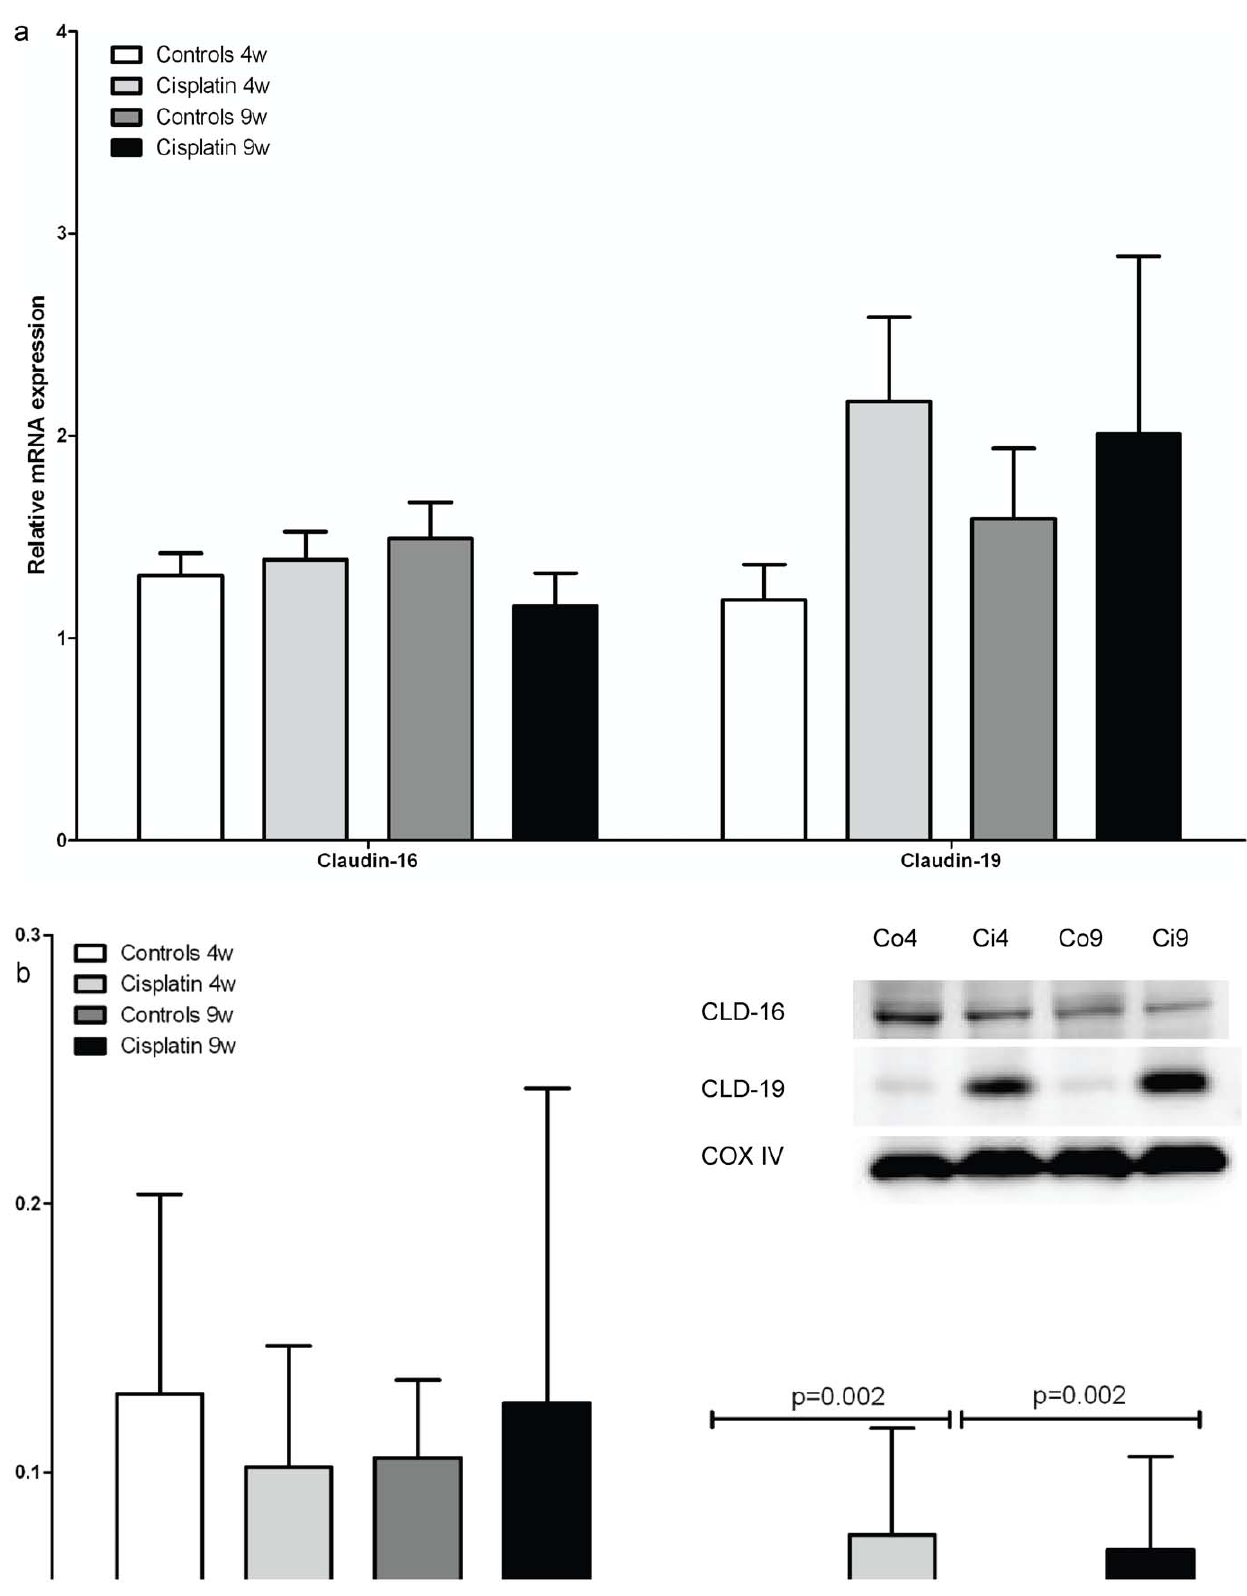
Figure 5. mRNA and protein expression levels of claudin-16 and claudin-19. a) Effect of cisplatin on renal mRNA expression levels of tight junction proteins claudin-16 and claudin-19. b) Expression of claudin-16 and claudin-19 protein in kidney tissue of rats was examined with Western blot analyses using claudin-16 and claudin-19 antibody (described in materials and methods). Data are presented as means 6 SD, each group